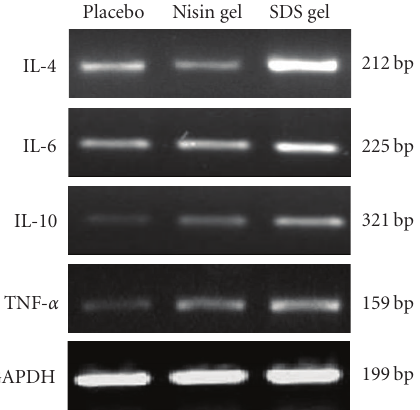
Figure 9: RT-PCR analysis of cytokine expression following intravaginal application of nisin (15.15 mM/day/14 days), SDS (56 μ M/day/14 days) and 1% placebo gels in rabbits. After sepa- ration of cells, they were subjected to RNA extraction as per the protocol given in the material and methods section. The expression of IL-4, IL-6, IL-10 and TNF- α . genes in nisin treated group was comparable to the placebo group. In contrast, expression of the cytokine genes was upregulated in SDS treated group. GAPDH blots confirmed roughly equivalent loading of RNA samples.